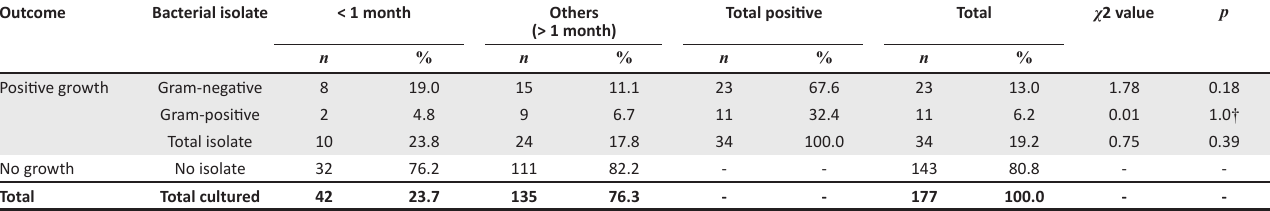
TABLE 4: Comparison of Gram-positive and Gram-negative isolates from bloodstream infection cases between neonates and other participants at the Federal Teaching Hospital, Ido-Ekiti , Nigeria, between June 2020 and February 2021. Outcome Bacterial isolate